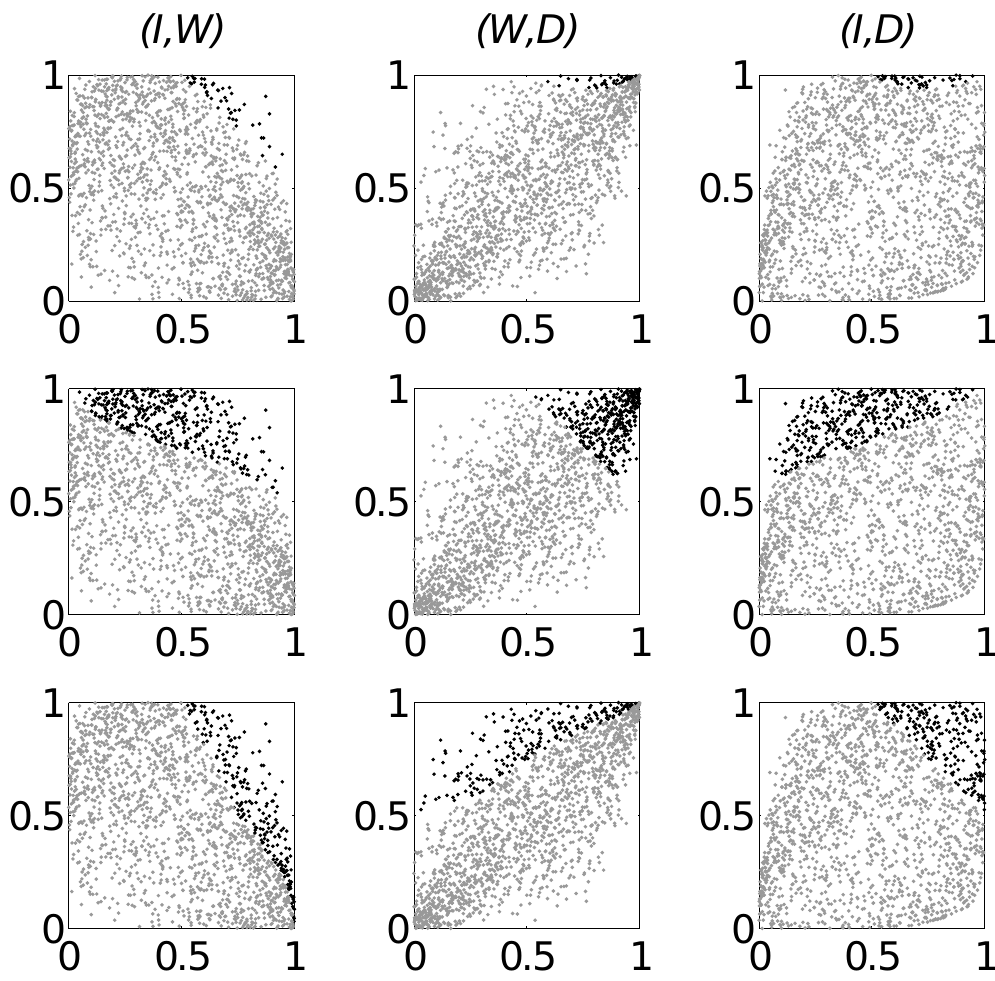
Fig. 2. Normalized rank scatter plots of three different couples of storm variables (per column). Each row shows the same plots, with different storms highlighted within each row. In the first row, the extreme storms with respect to I and W are selected (i.e., storms found in the upper-right corner of the (I,W) plane), and are indicated in black in each of the plots of the first row. For the second and the third row, extreme storms with respect to, respectively (W,D) and (I,D) are selected, and marked in